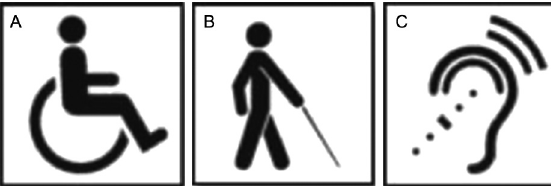
Fig. 4. International symbols of